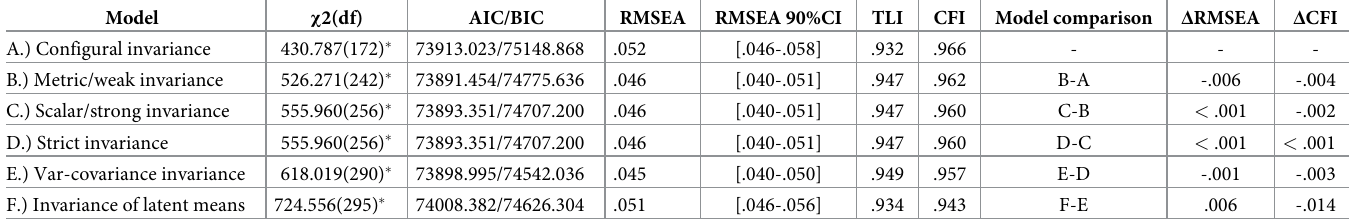
Table 5. Testing measurement invariance of the RTSQ across